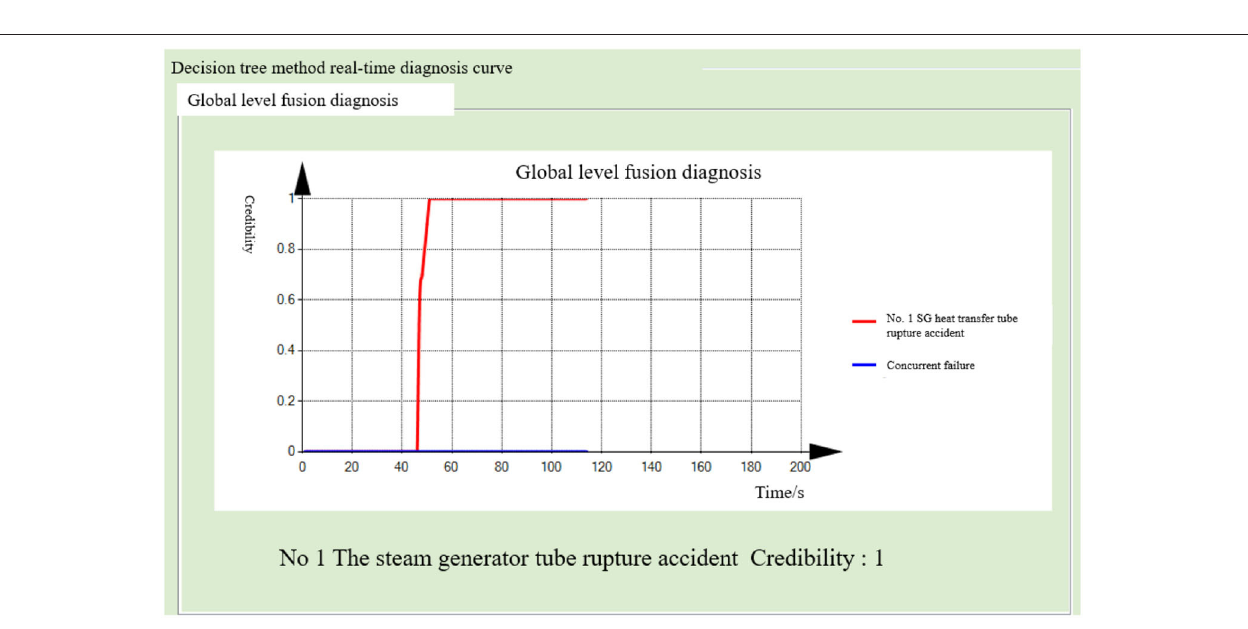
FIGURE 17 | Global-level fusion diagnosis result (decision tree